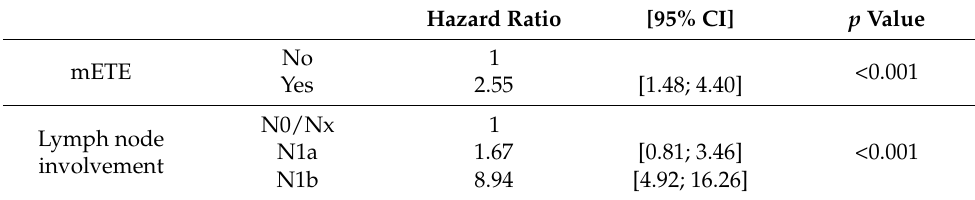
Table 2. Multivariate analysis of factors associated with a subsequent